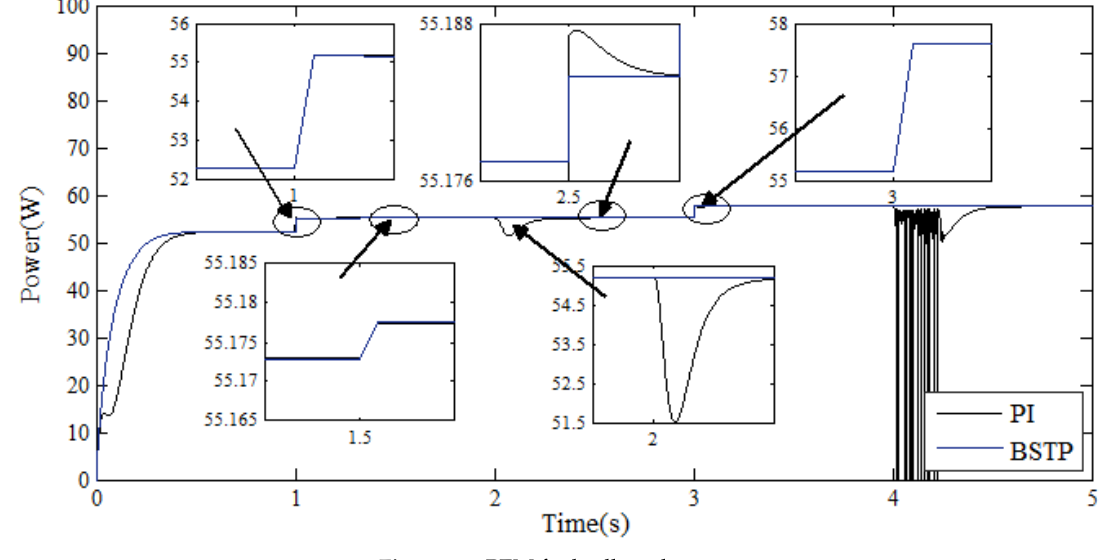
Figure 16. PEM fuel cell stack